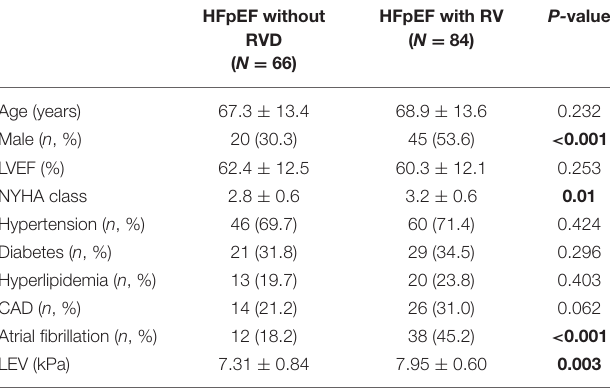
TABLE 6 | Comparison of clinical data in HFpEF patients with or without RVD.